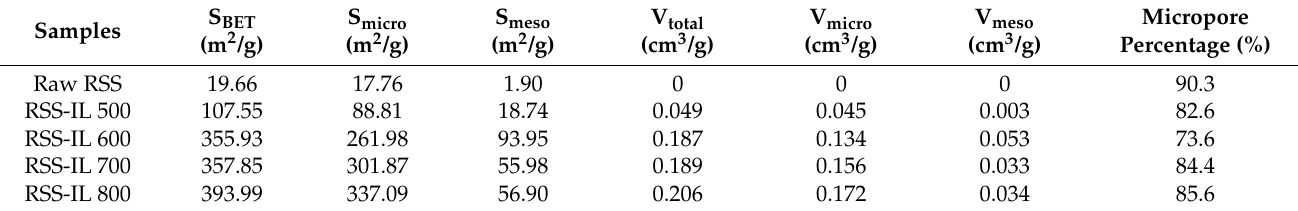
Table 2. BET surface area, total pore volume, and micropore volume of the prepared AC samples.